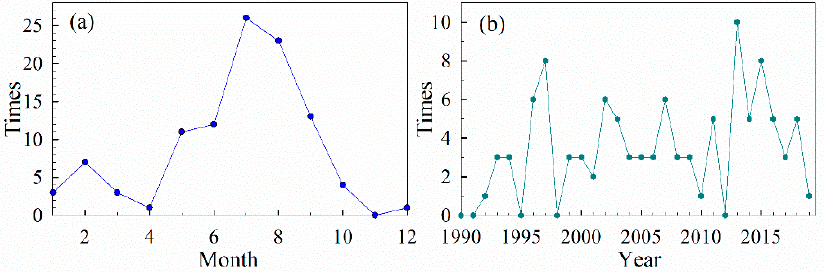
Figure 8. Number of advances of advancing glaciers occurring in different ( a ) months and ( b ) years.